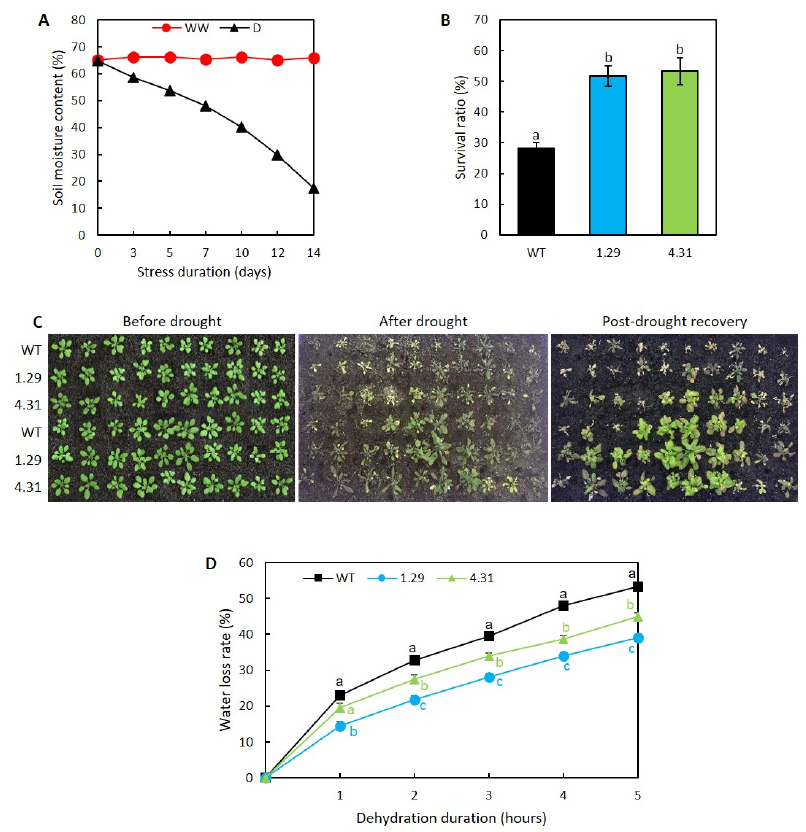
Figure 2. Survival test and water loss assay of transgenic Arabidopsis ectopically expressing GmRR34 (independent lines 1.29 and 4.31). ( A ) Monitored soil moisture content (SMC) during drought treatment for survival test ( n = 6 reading points). ( B ) Post-drought survival ratios of wild-type (WT)